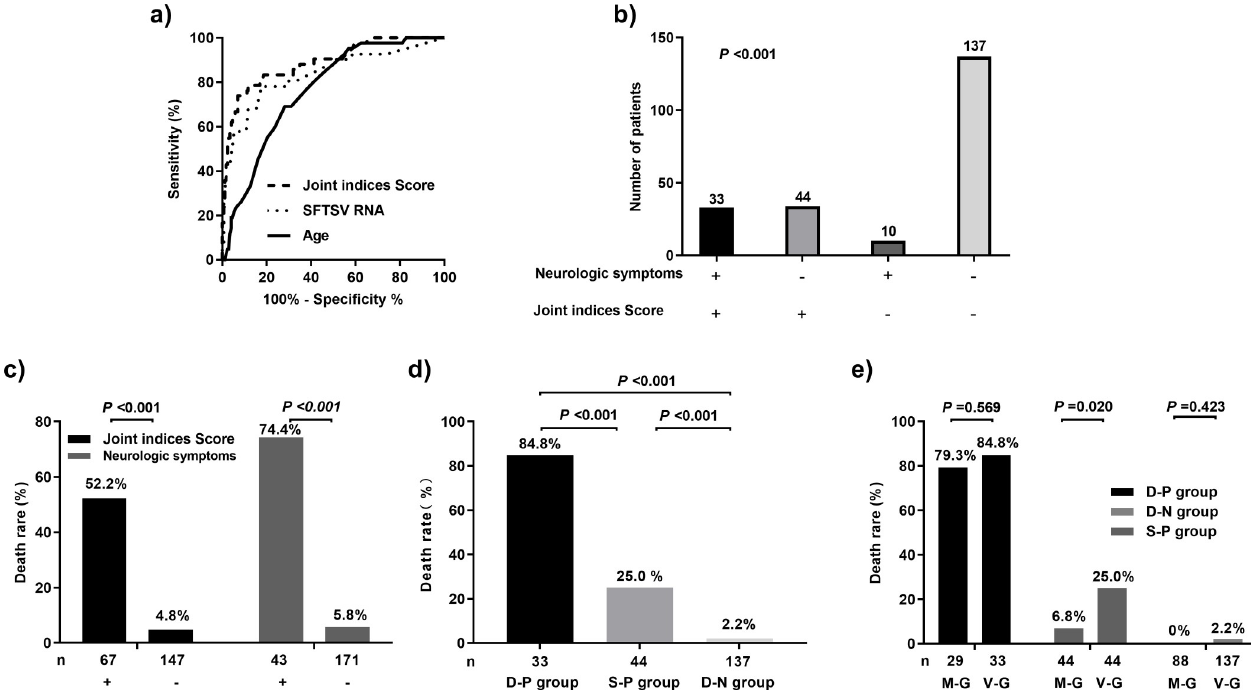
Fig 2. Verification of the proposed clinical scoring model for predicting mortality in patients with severe fever with thrombocytopenia syndrome (SFTS). (A) Receiver operating characteristic (ROC) curve for predicting mortality in patients with SFTS in the verification group. (B) Consistency between the joint indices score and the neurological symptoms in the verification group. (C) Mortality distribution of patients with SFTS according to each indicator in the verification group. (D) Mortality distribution of patients with SFTS according to the two combined indicators in the verification group. (E) Comparison of mortality in subgroups in the modeling and verification